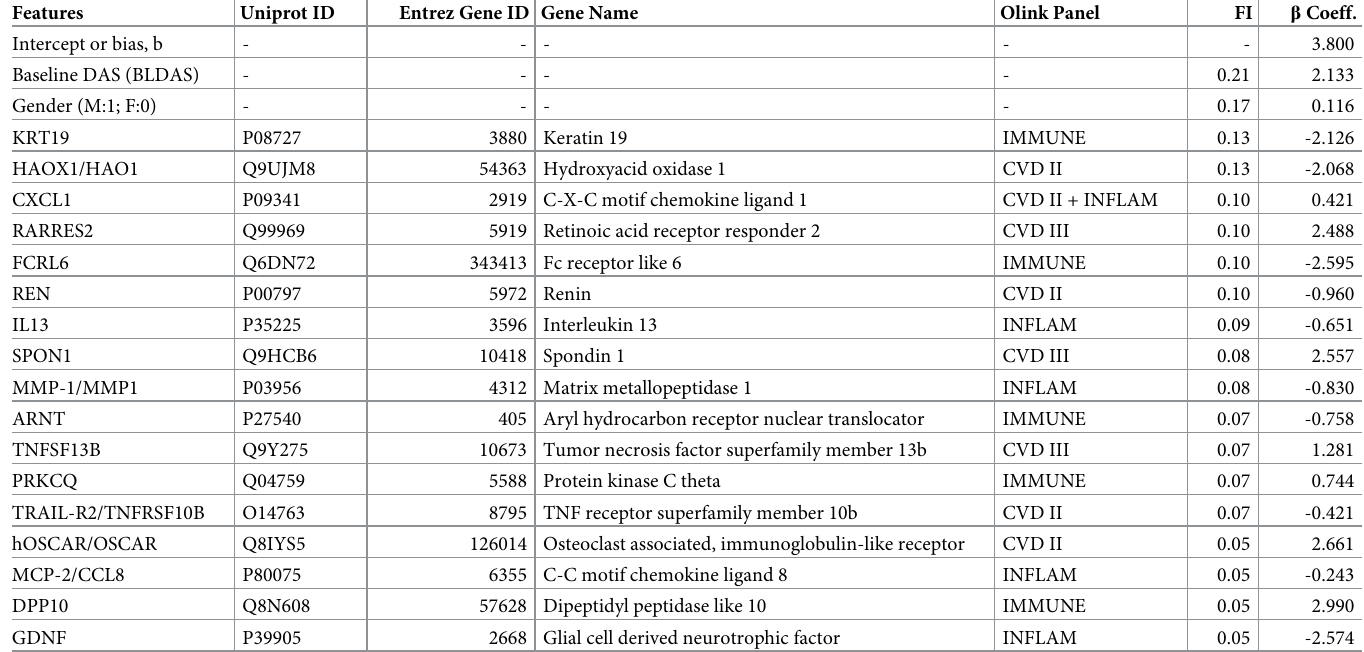
Table 3. Plasma protein signature, along with gender and baseline DAS (BLDAS) for anti-TNF treatment response prediction. Feature Importance (FI) is defined as the fraction of models a feature appears in. Beta ( β ) Coefficients are the effect sizes of features obtained from the logistic regression analysis. DAS = Disease activity score.